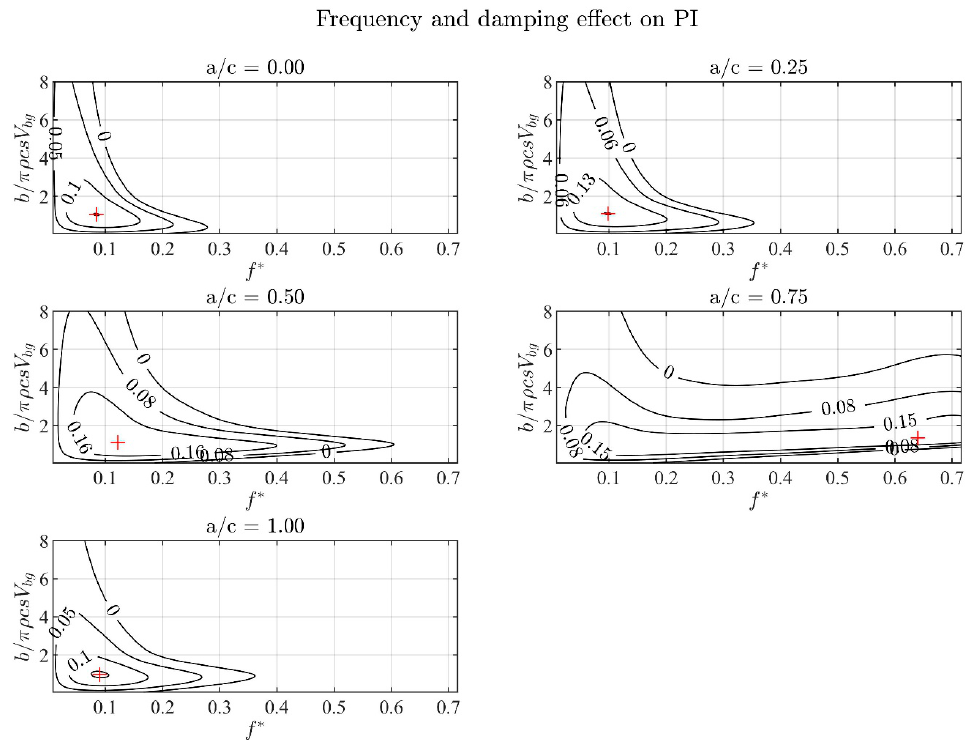
Figure 6. Effect of pitch amplitude on the efficiency of the device for bg c Vb s f ∗ = 1/ π . The e ffi ciency rises linearly with the pitch amplitude. The dashed line represents the results of [39], the line with crosses represents the results of the present method with e ffi ciency defined by the plunging amplitude, and the line with diamonds shows the e ffi ciency calculated by including the pitching motion.